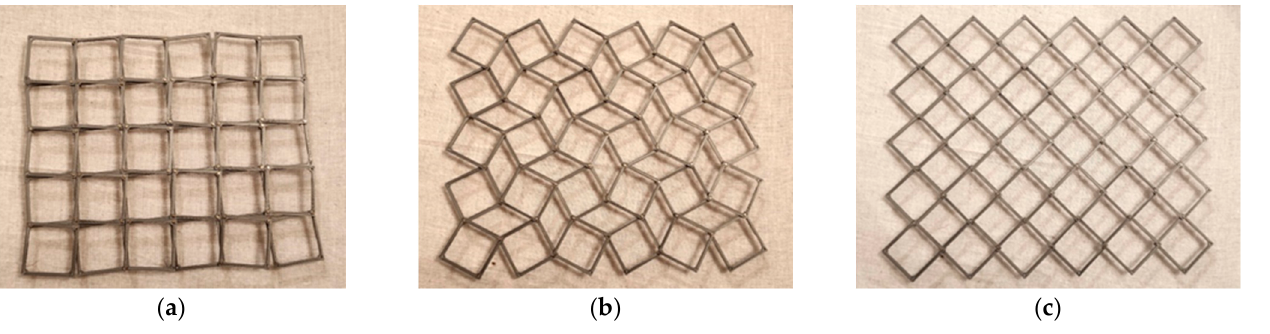
Figure 12. A 5 × 6 auxetic structure built with square frames connected by rotation axes on their surface in three positions closed ( a ), partially open ( b ) and open ( c ). The rigid square frames presented can undergo rotation on the mounted rotation